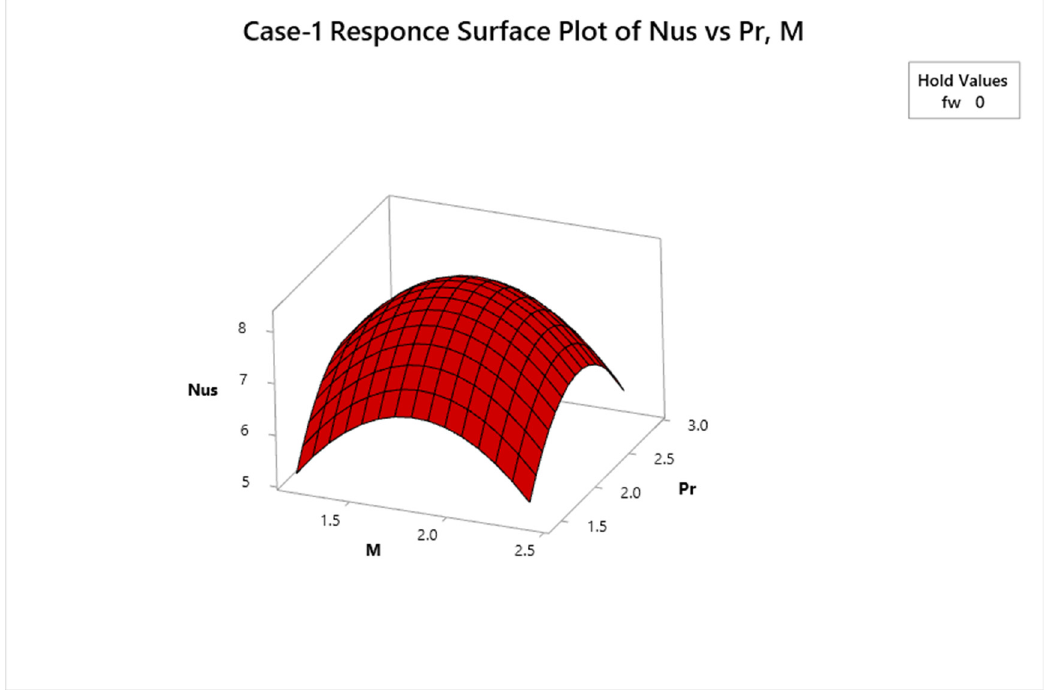
Figure 11. RSM plot for Nusselt number Vs Pr, M .